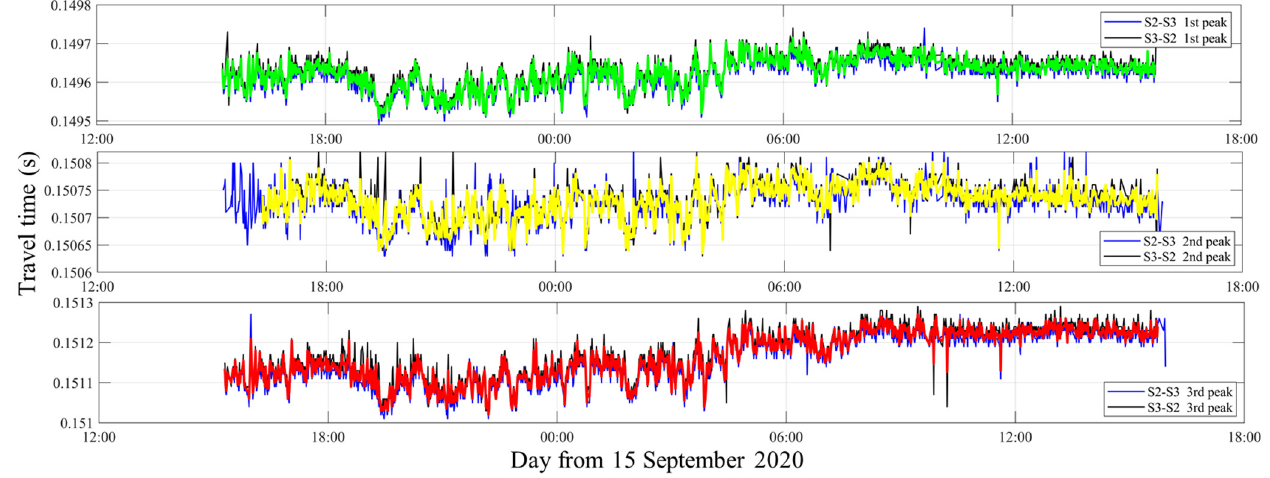
Figure 3. The travel time of three arrival peaks between S2 and S3 .